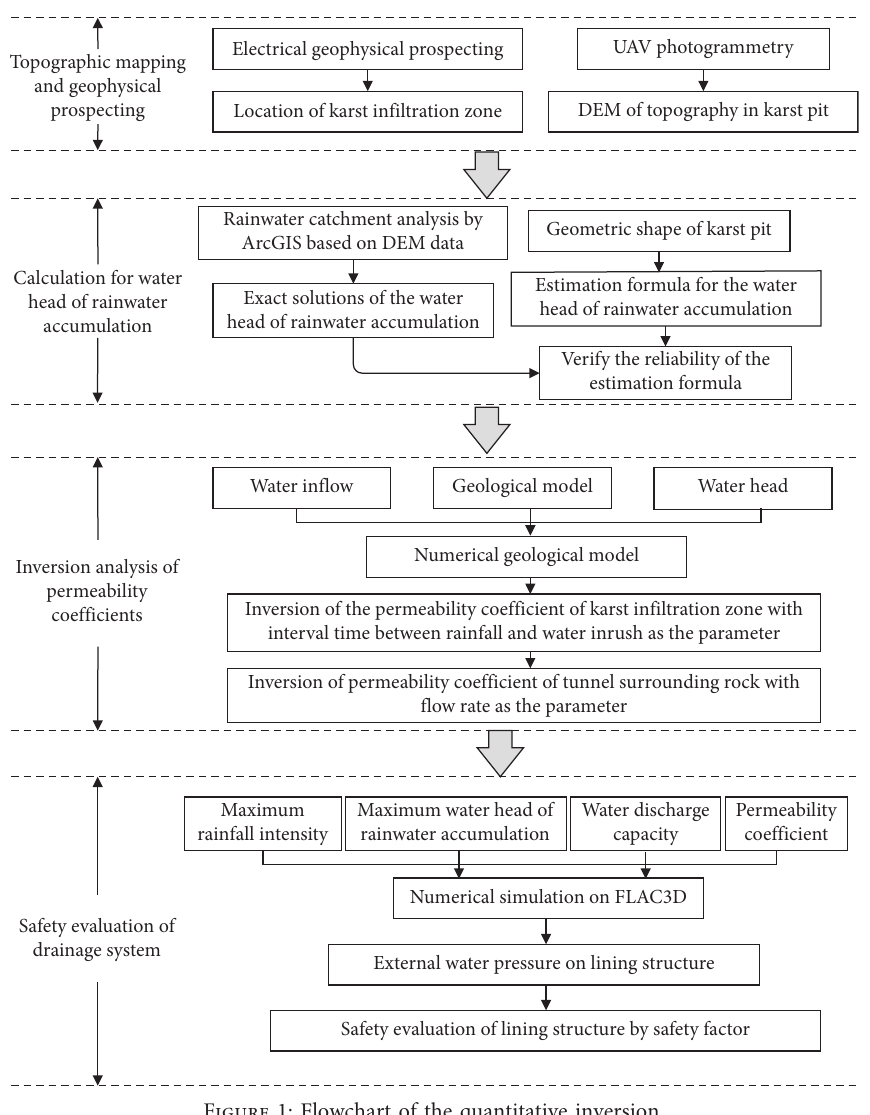
Figure 1: Flowchart of the quantitative